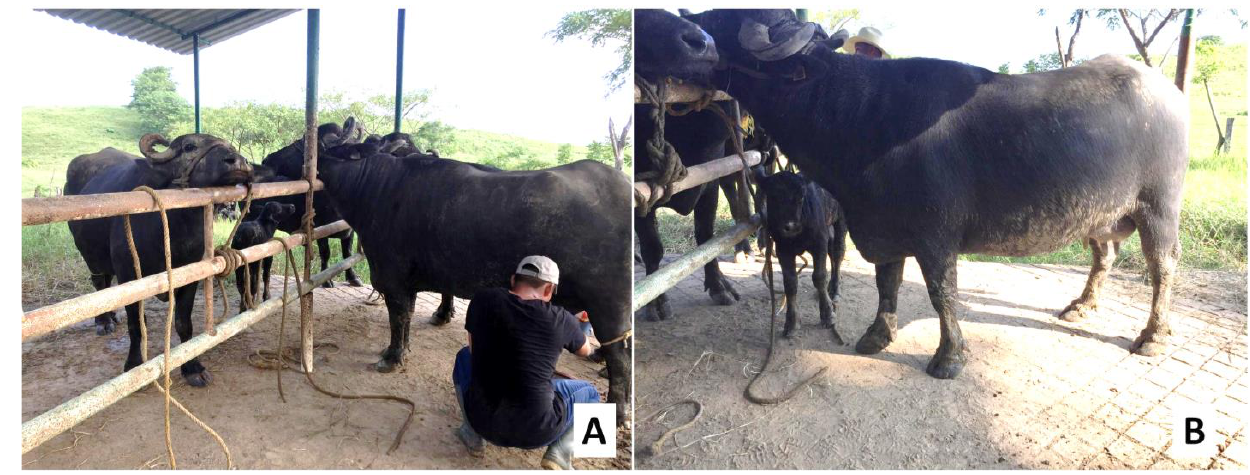
Figure 5. Manual and auditory stimulation during milking in dairy buffalo cows ( Bubalus bubalis ). ( A ) Manual stimulation by the milker in the form of massages to foster adequate milk ejection. ( B ) Presence of the calf to provide tactile and auditory stimulation prior to milking.